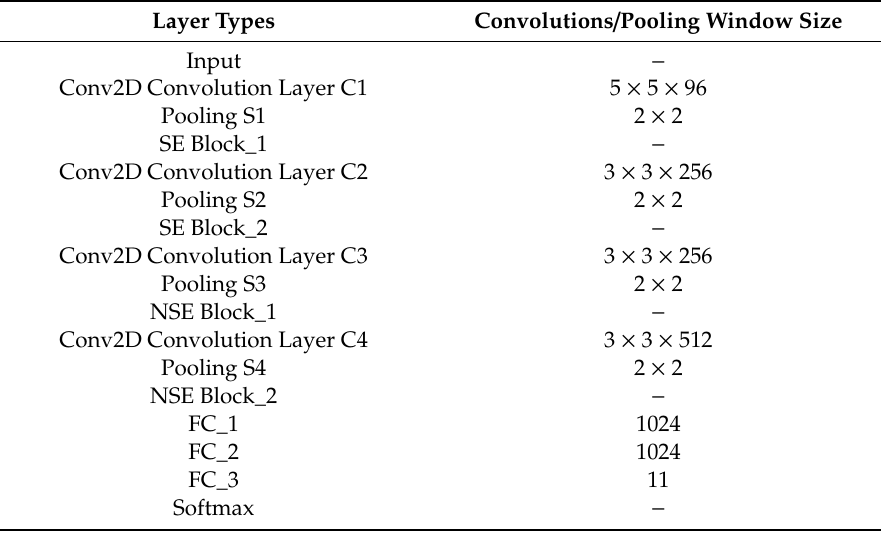
Table 2. Parameters setting of the network FRN.